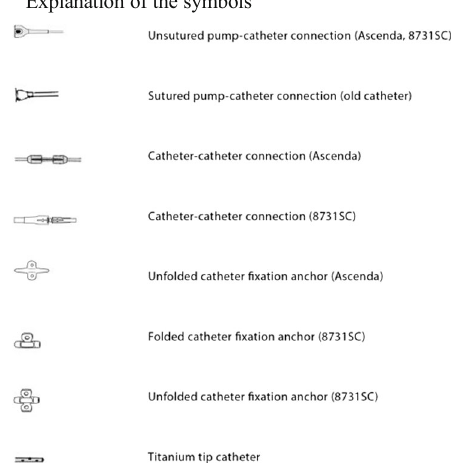
Explanation of the symbols